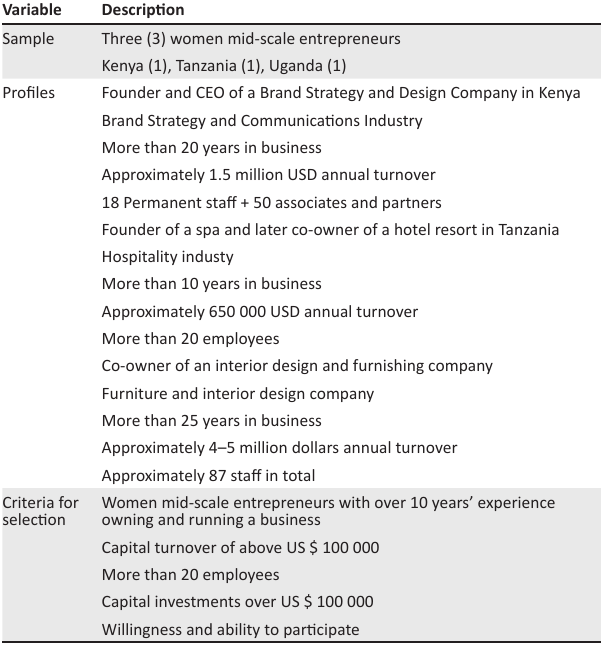
TABLE 1: An overview of the participants’ profile. Variable